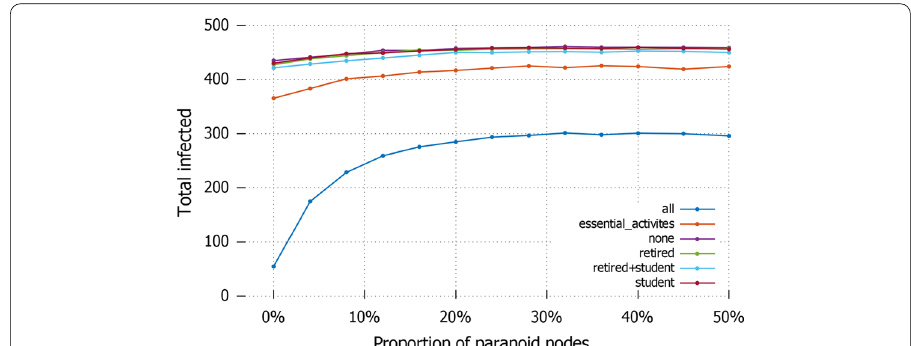
Fig. 14 Proportion of paranoid nodes (b) Different paranoid nodes distribution compared with the number of total infected by lockdown